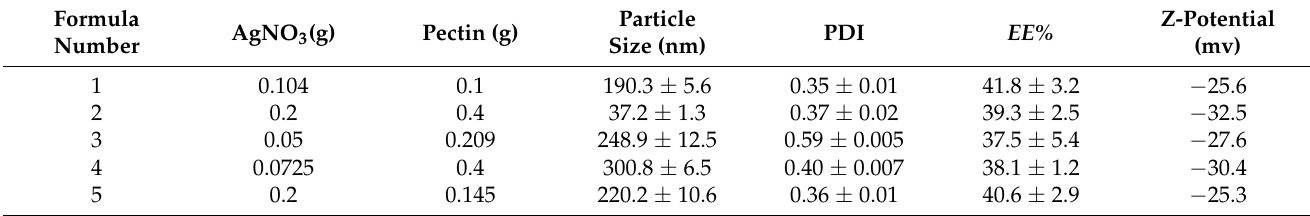
Table 2. Formulation parameters and characterization of BBE -AgNPs. Values of particle size, PDI and EE% are presented as means of 3 samples ± SEM. AgNO 3 , silver nitrate; PDI, Poly dispersity index; EE% , Entrapment Efficiency.